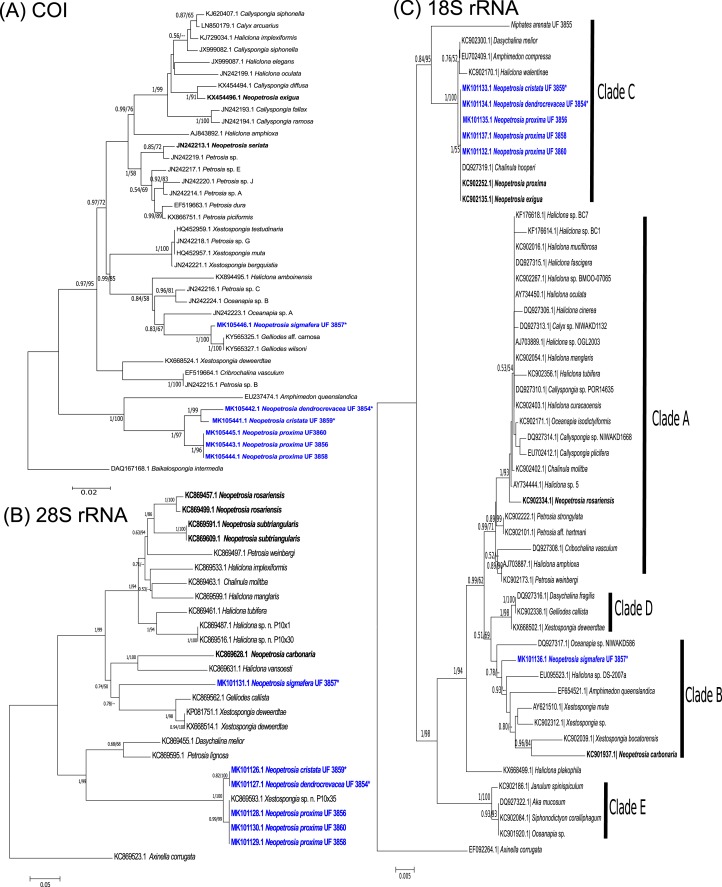
Phylogenetic trees.Bayesian and maximum likelihood topology generated from partial sequences spanning the (A) Folmer (5′) region of the cox1 gene, (B) D1–D2 region of the 28S rRNA gene, and (C) 18S rRNA gene, from Haplosclerida taxa generated in this study (blue) and sequences downloaded from GenBank. Clades in (C) correspond to clades assigned by Redmond et al. (2013). Sequences in bold highlight other Neopetrosia species. Bootstrap values less than 50% have been omitted from the trees. Numerical values at nodes show Bayesian posterior probabilities followed by RAxML bootstrap values. Nodes with “—” refer to the absence of the node generated by RAxML. Type specimens are indicated by an asterisk at the end of the specimen’s catalogue number.